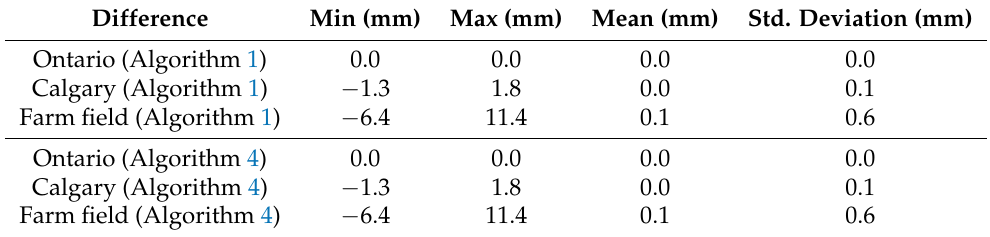
Table 1. Difference in millimeters between the ArcGIS Pro calculated geodesic distances and ours. Difference Min (mm) Max (mm) Mean (mm) Std. Deviation (mm) Ontario (Algorithm 1) 0.0